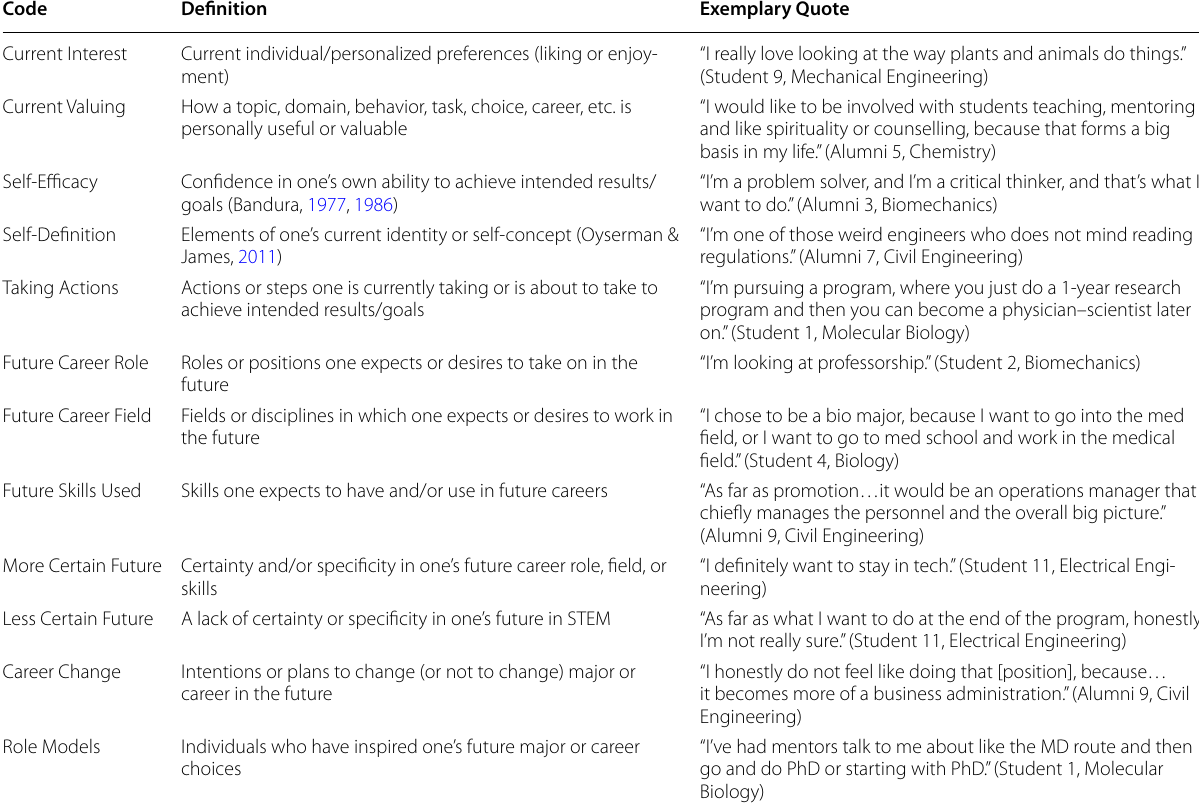
Table 1 Codes related to northeast AMP participants’ possible future selves in